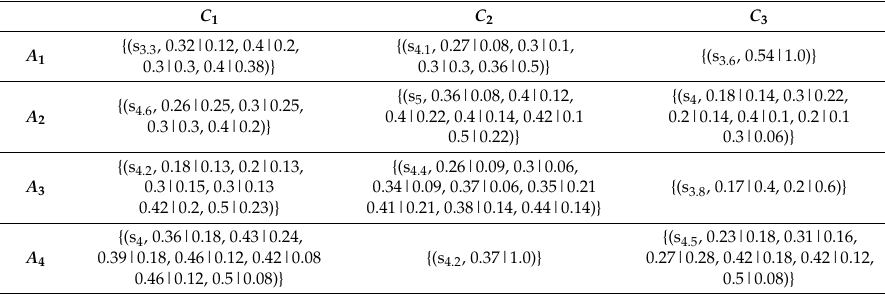
Table 5. Aggregated HPFLE group decision matrix using hesitant probabilistic fuzzy linguistic weighted geometric (HPFLWG)